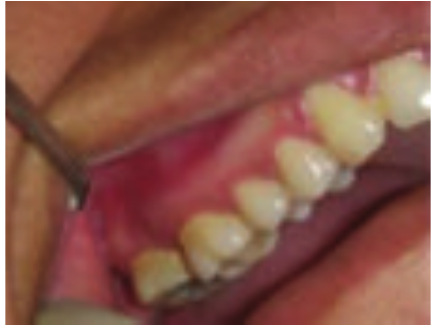
Figure 6: Healing of draining